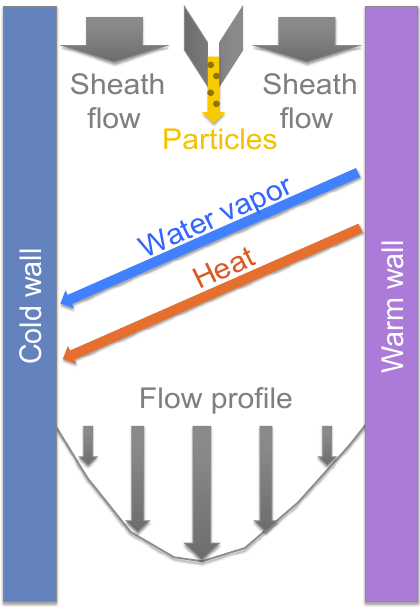
Figure 1. Schematic representation of an idealized CFDC. A particle-laden flow is passed between two ice-coated walls that are held at different temperatures below 0 ◦ C. This results in water va- por and heat diffusing from the warm to the cold wall. Supersatu- ration, with a maximum near the centerline, results from the non- linear relationship of water vapor saturation with respect to temper- ature. Sheath flows along each wall are meant to isolate particles to a central lamina at or near the supersaturation maximum, which also theoretically restricts the temperature and supersaturation to which they are